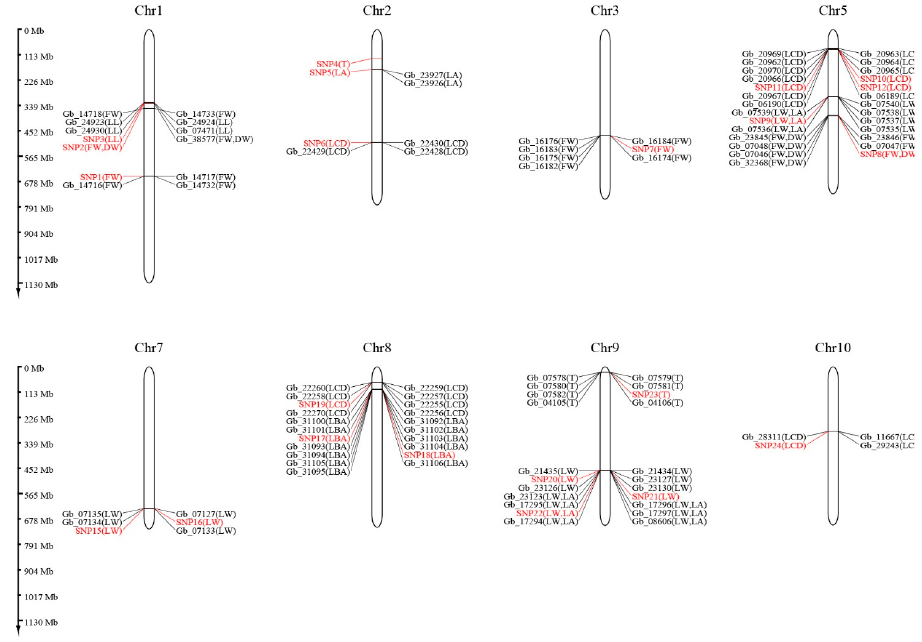
Figure 4. A physical map of SNPs (red) and genes (black) related to leaf